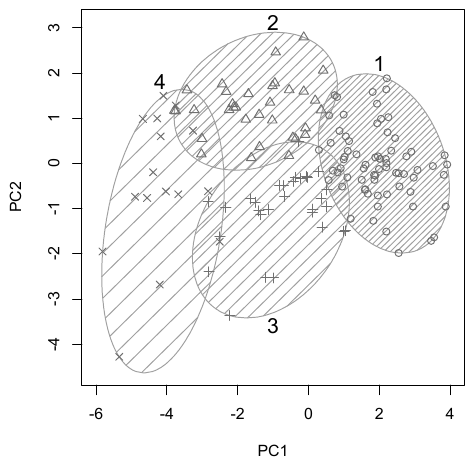
Figure 2. K ‐ means clustering of all participants into 4 clusters, plotted along the first 2 components. Each cluster is numbered and shown as shaded ellipse. Shading density reflects within ‐ cluster participant density and plotting symbols indicate cluster membership.